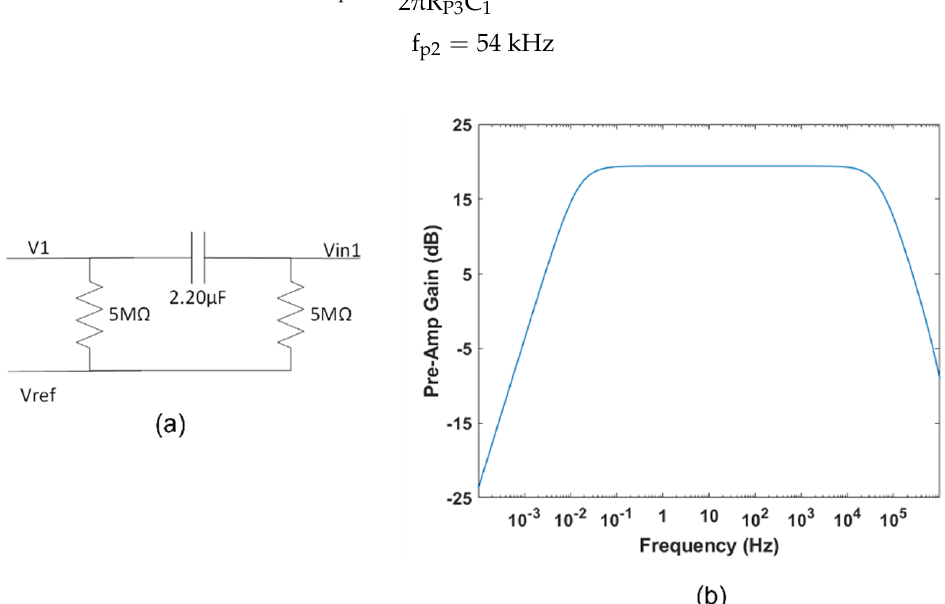
Figure 3. ( a ) The detailed high − pass filter; ( b ) gain vs. frequency.